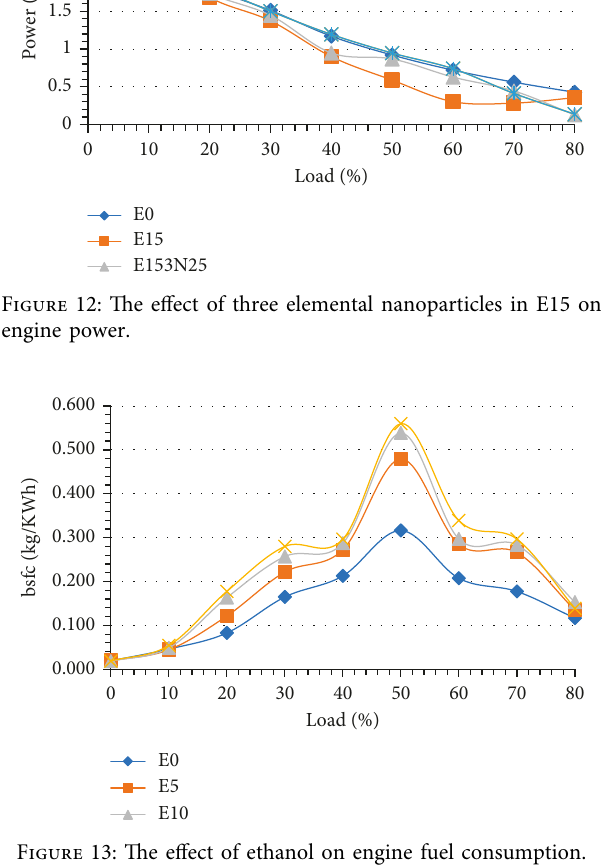
Figure 11: The effect of 3 elemental nanoparticles in E10 on engine power.